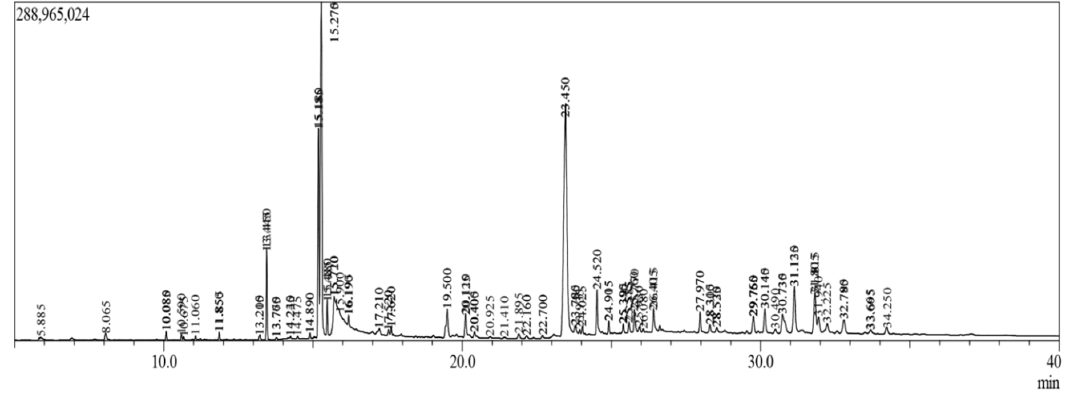
Figure 1. Total ionic chromatogram (TIC) of methanolic extract of T. crispa whole plants by GC-MS. Table 1. Quantitative compounds identified from methanol extract of T. crispa by GC-MS